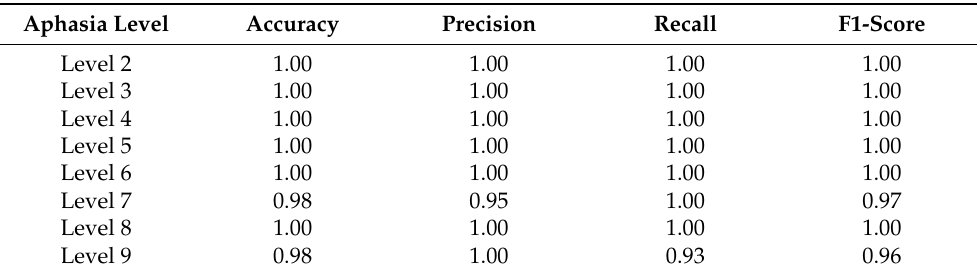
Table 12. Classification report of DNN model for aphasia severity level classification using 20 s audio chunks.